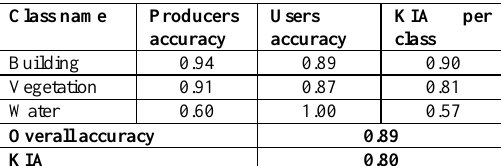
Table 3: Accuracy assessment and kappa statistics